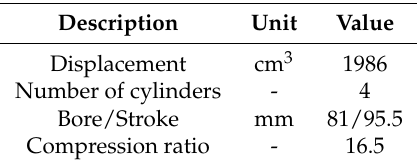
Table 2. Geometrical data of the engine.